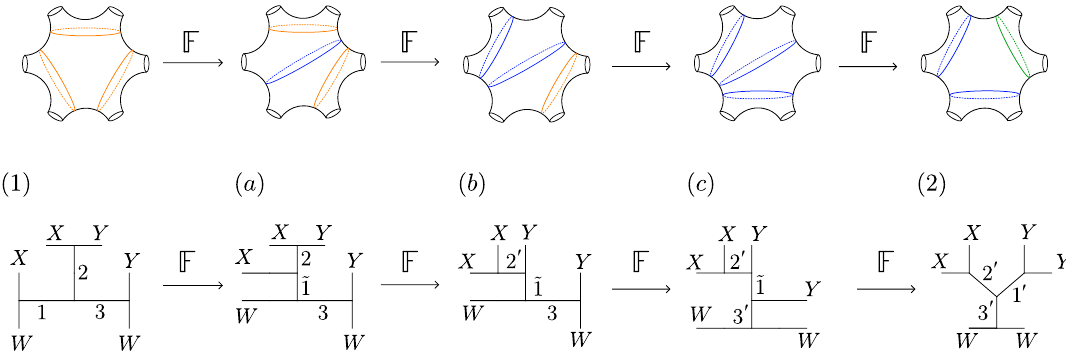
Figure 3 . The sequence of elementary crossing moves relating two different star channel decompo- sitions. We show the full (top) and simplified (bottom) versions of this